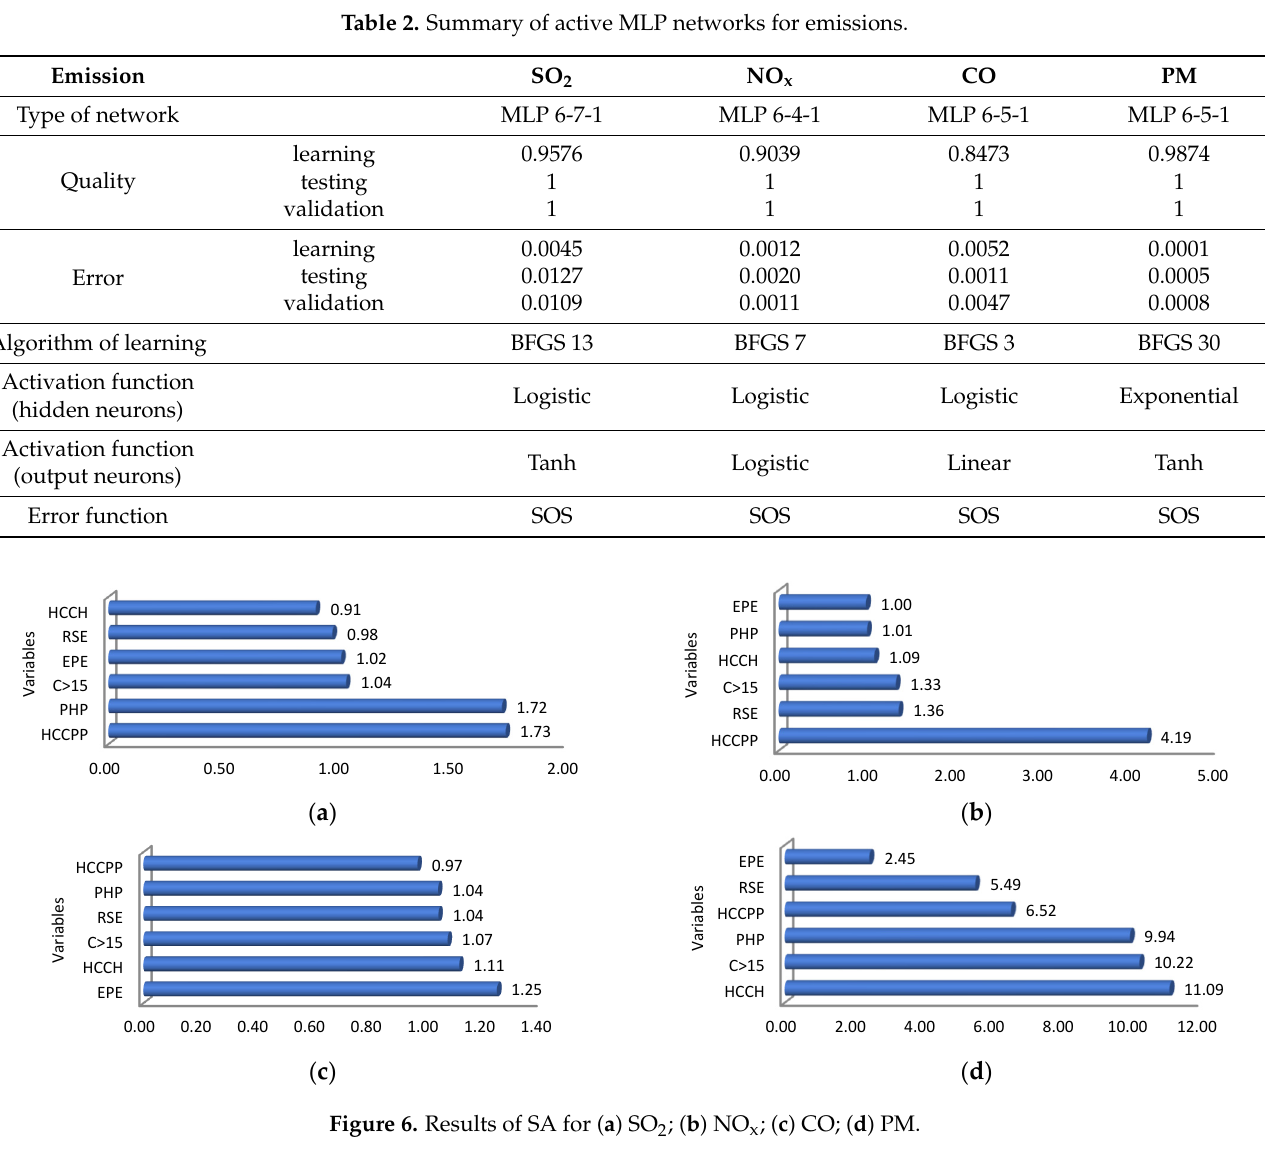
( d ) Figure 7. Observed and modelled by MLP value of emission: ( a ) SO 2 ; ( b ) NO x ; ( c ) CO; ( d ) PM . The trends observed for individual input variables (Table 3) led to several hypo ‐ thetical scenarios of their course and, based on them, predictions of SO 2 , NO x , CO and PM emissions were made.